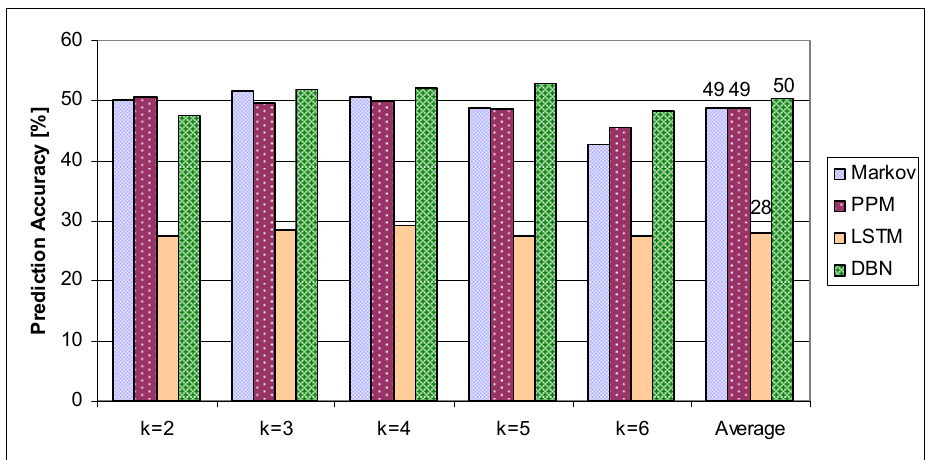
Figure 7. Prediction rate without the mood variable through k ‐ fold cross ‐ validation.